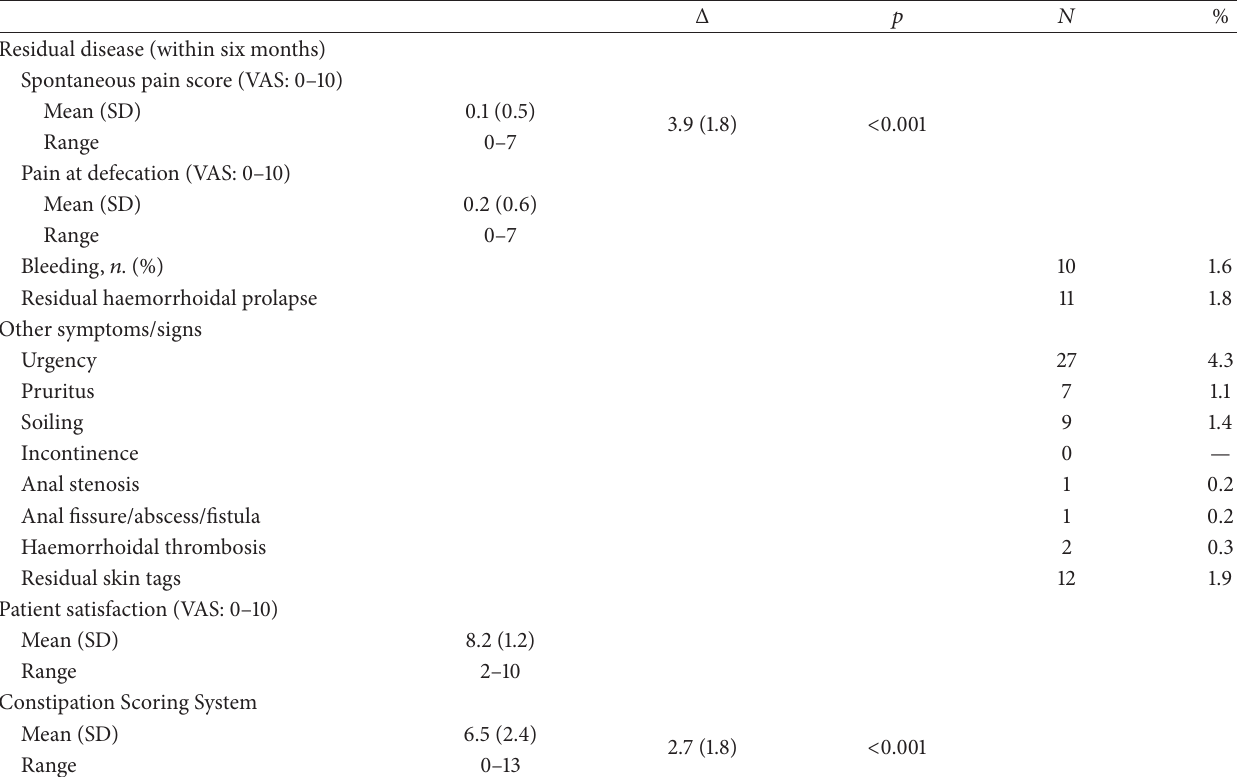
Table 4: Follow-up at six months in 621